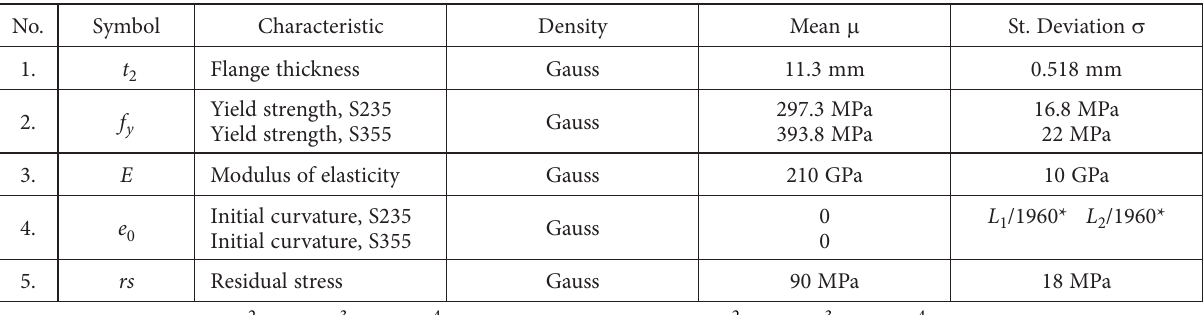
Table 1. Statistical characteristics of input imperfections